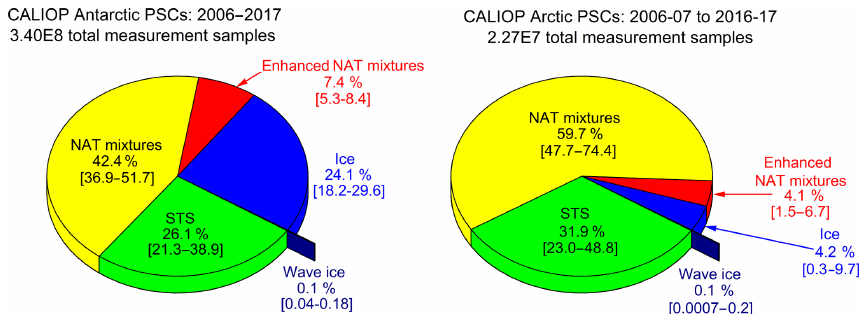
Figure 25. Composition breakdown of PSCs observed by CALIOP in the Antarctic and Arctic during 2006–2017. The percentages are averages over the 12 Antarctic and 11 Arctic seasons in the data record, and the minimum and maximum percentages in any one season are indicated by the numbers in brackets. Data are restricted to altitudes of 4km or higher above the tropopause to avoid distortion of the statistics by ubiquitous underlying cirrus.